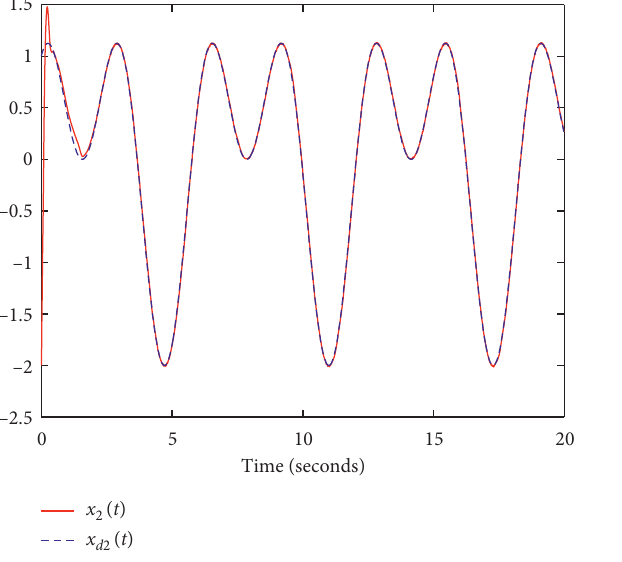
Figure 4: The control inputs u